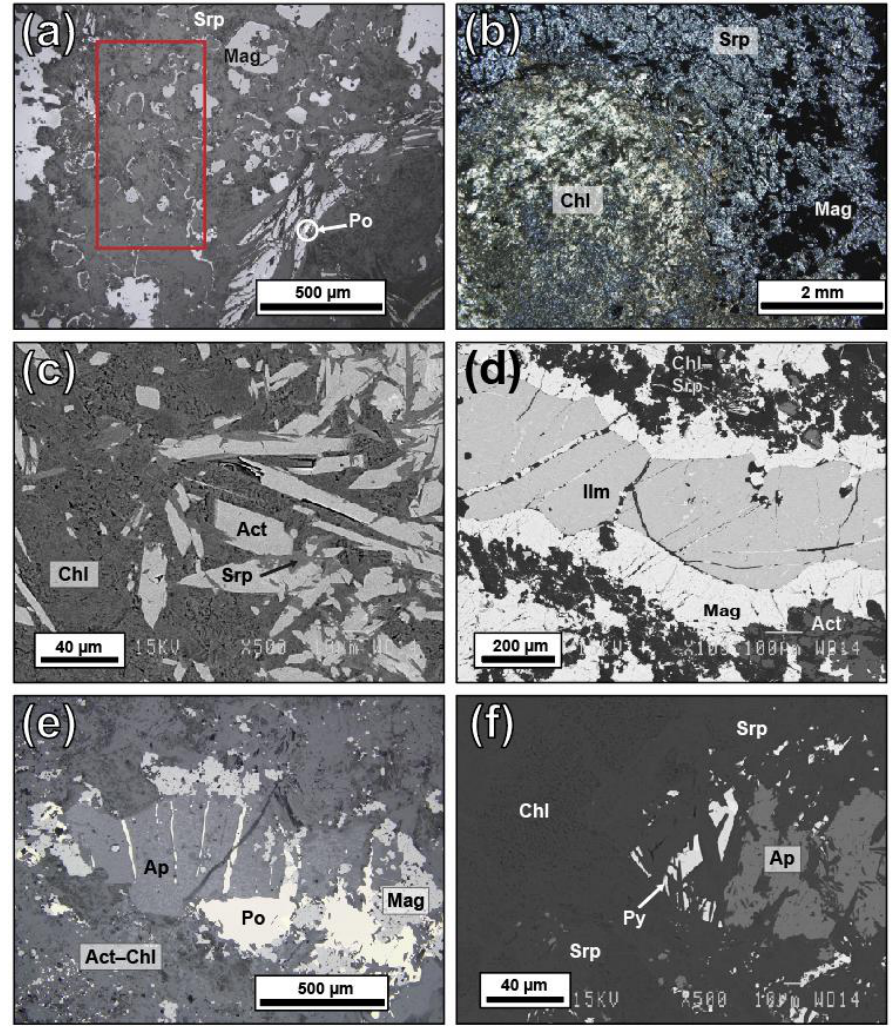
Figure 5. Images showing the textures of samples: ( a ) MS17-45, with linear magnetite that rim olivine grains pseudomorphed by serpentine and talc; ( b ) MS17-45, chlorite cluster in a magnetite-serpentine matrix; ( c ) MS17-28, edge of an actinolite-bearing chlorite cluster; ( d ) MS17-28, ilmenite with magnetite exsolutions rimmed by magnetite with ilmenite exsolutions, in a chlorite–amphibole matrix; ( e ) MS17-02, assemblage of apatite, pyrrhotite, and small granular magnetite; and ( f ) MS17-37, serpentine and chlorite with interstitial apatite and pyrite. In the red rectangle ( a ), pixel counts (GIMP software) indicate 90.4 vol % of serpentine + brucite and 9.6 vol % of inclusion-free magnetite. Images have been obtained using a conventional microscope with both ( a , e ) reflected light and ( b ) transmitted light, as well as ( c , d , f ) with a backscattered electron SEM. Mineral abbreviations are as reported in the literature [34].